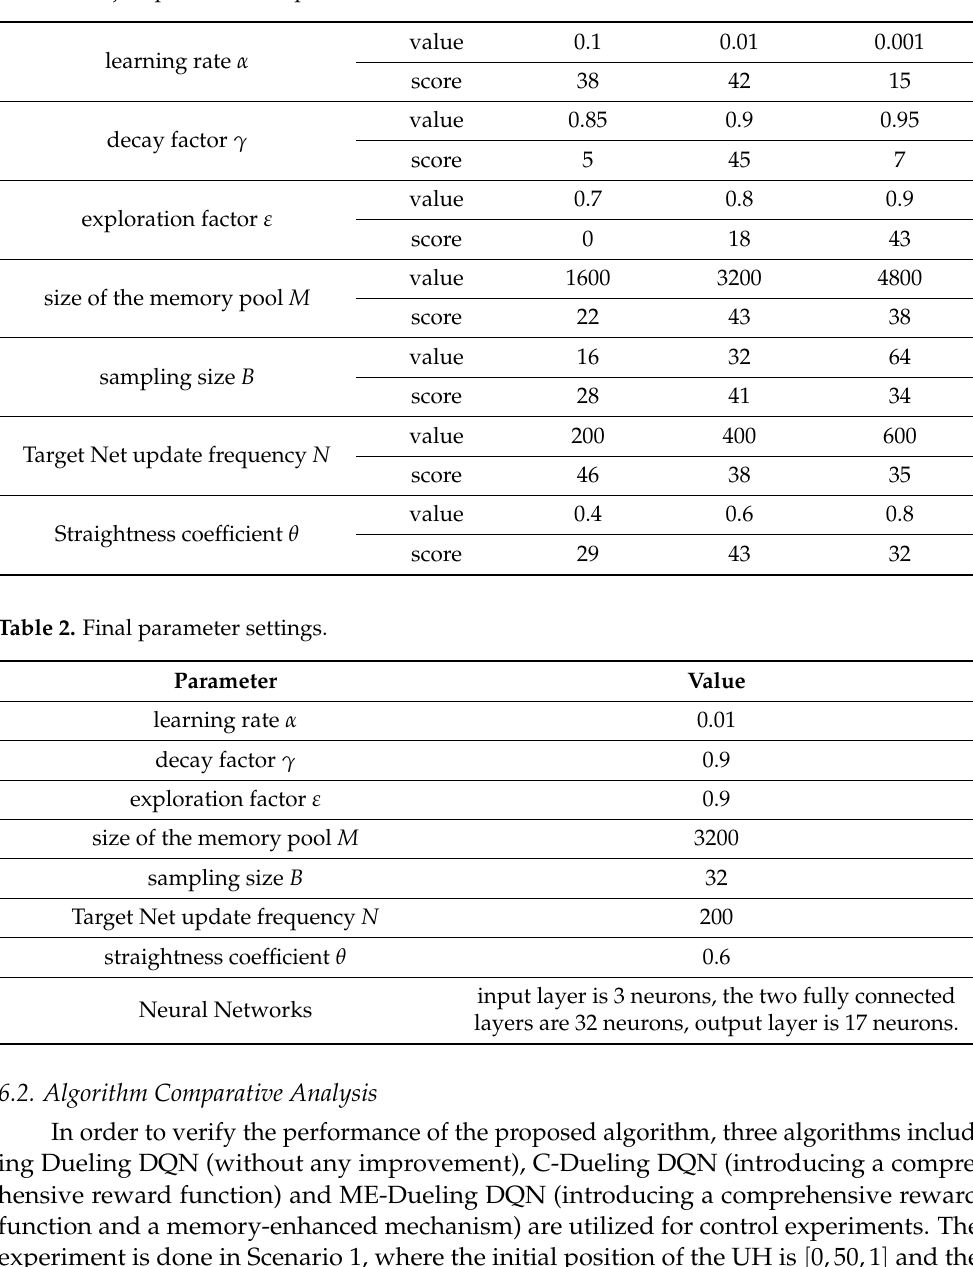
Table 1. Adjust parameters experimental results.